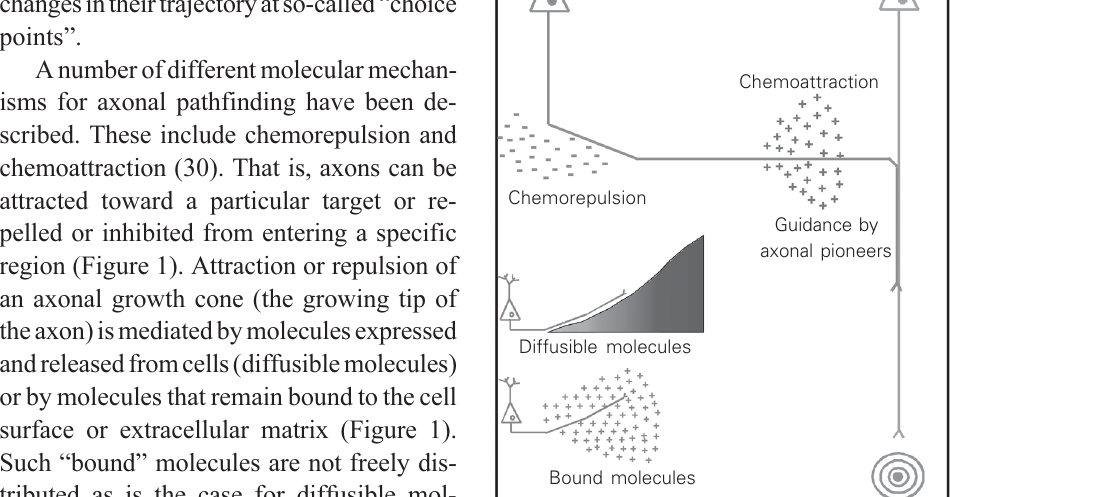
Figure 1. Axonal guidance mechanisms in the developing nervous